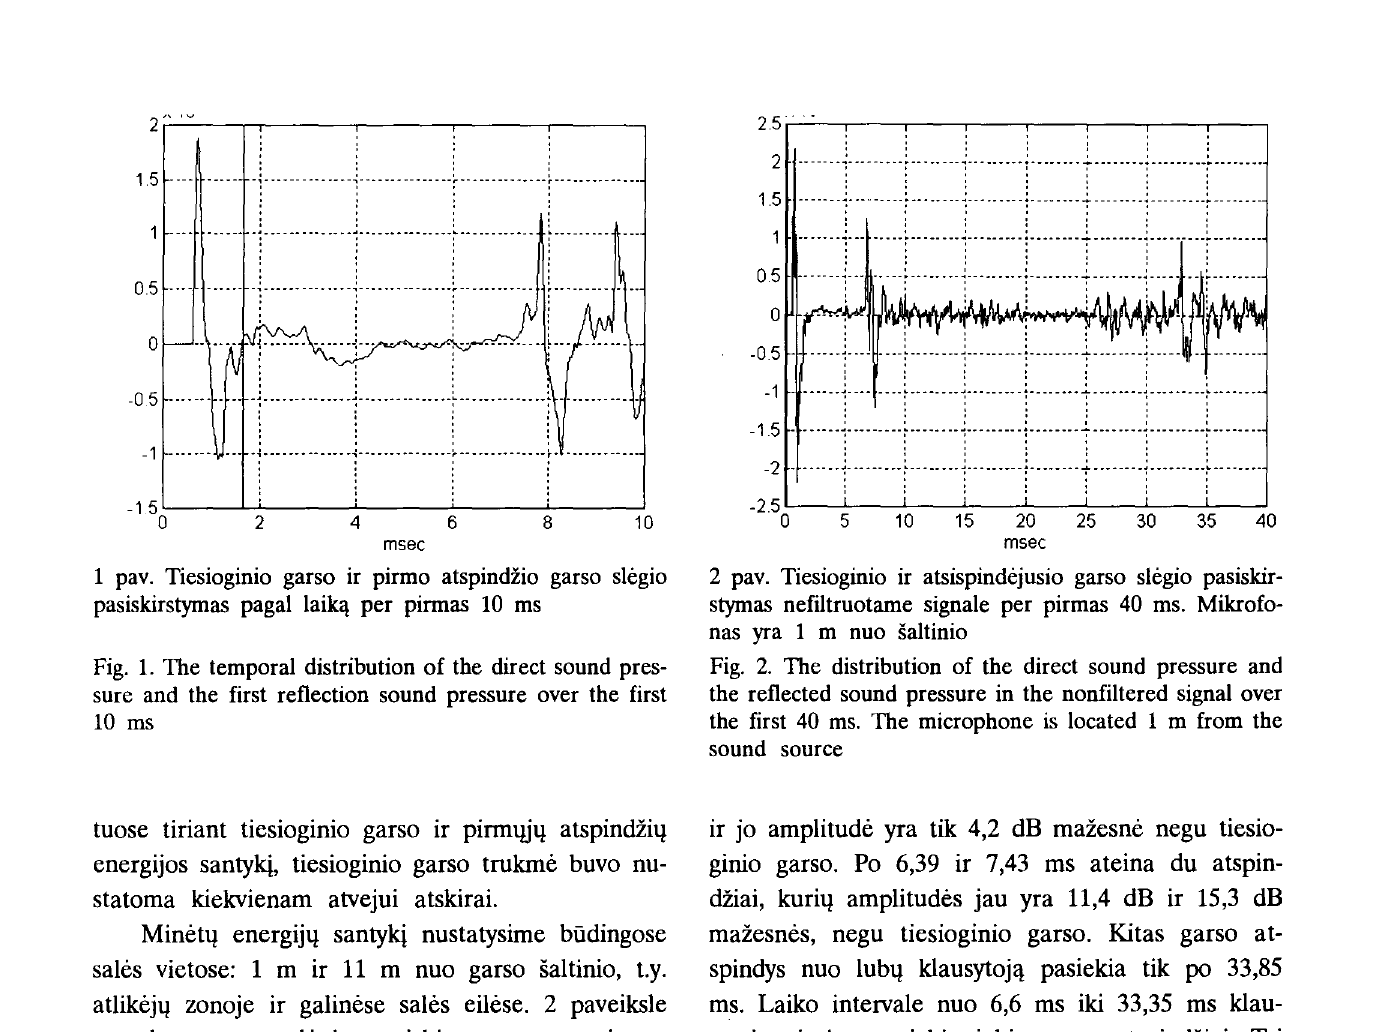
3 pav. Tiesioginio garso ir atspindziq pasiskirstymo pagal